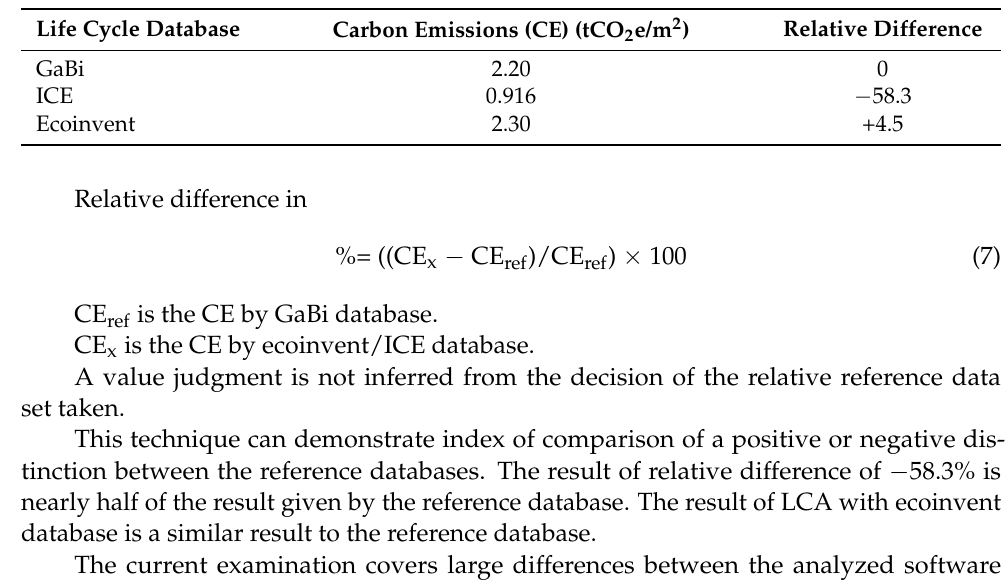
Table 10. Relative difference in findings of carbon